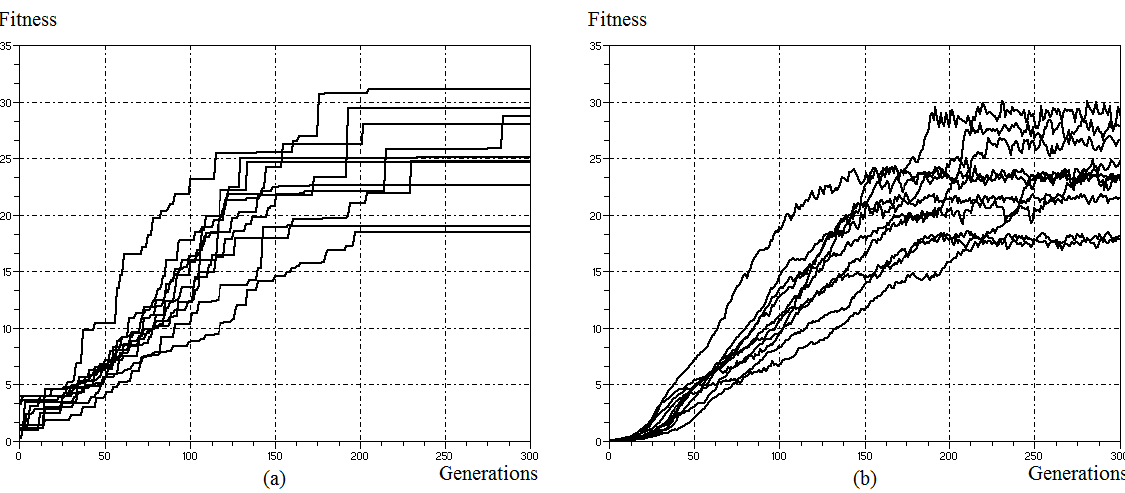
Figure 11. Evolution of population fitness in GA-MMC for 10 simulations (tilt angle equal to 30°) [13]. ( a ) Maximum Fitness. ( b ) Average